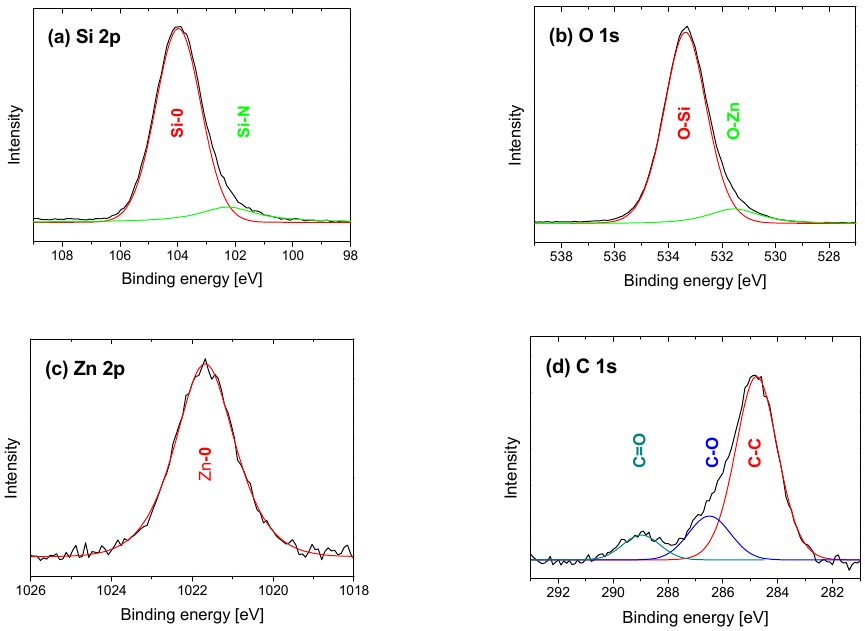
Figure 5. XPS spectra for the ( a ) Si 2p, ( b ) O 1s, ( c ) Zn 2p, and ( d ) C 1s orbitals of the Zn-SiO x film grown onto Si with a secondary precursor flow rate of 100 µl/min.